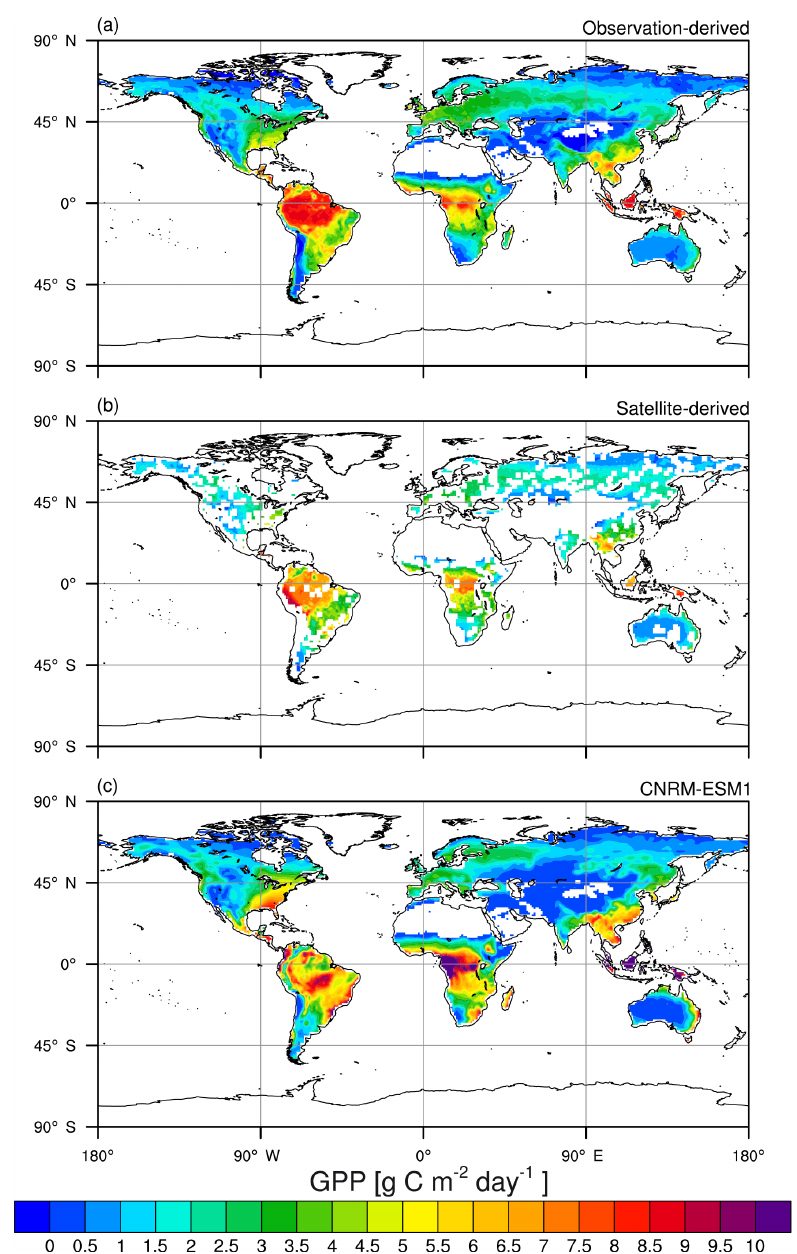
Figure 11. Annual-mean terrestrial gross primary production (GPP). Values are given for (a) observation-derived FluxNet-MTE (Jung et al., 2011) averaged over 1986–2005, (b) satellite-derived observation from MODIS over 2000–2013 and (c) CNRM-ESM1 over